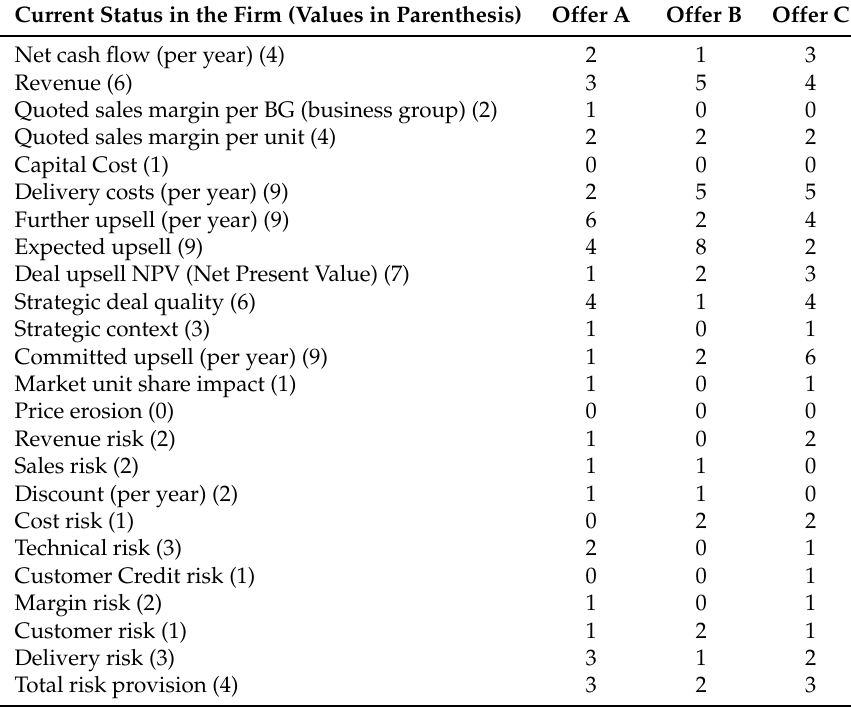
Table 1. Model input data: status of the firm and impact of the